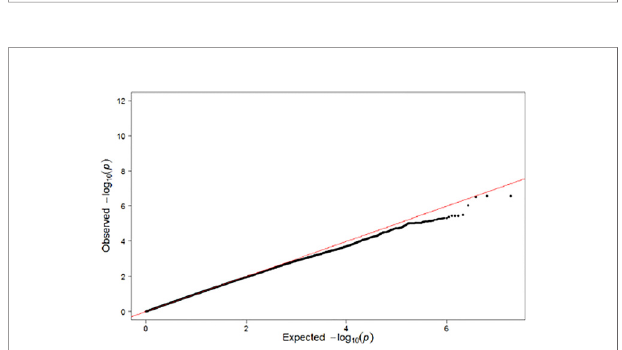
FIGURE 4 | QQ Plot for Single SNP-Based Analysis